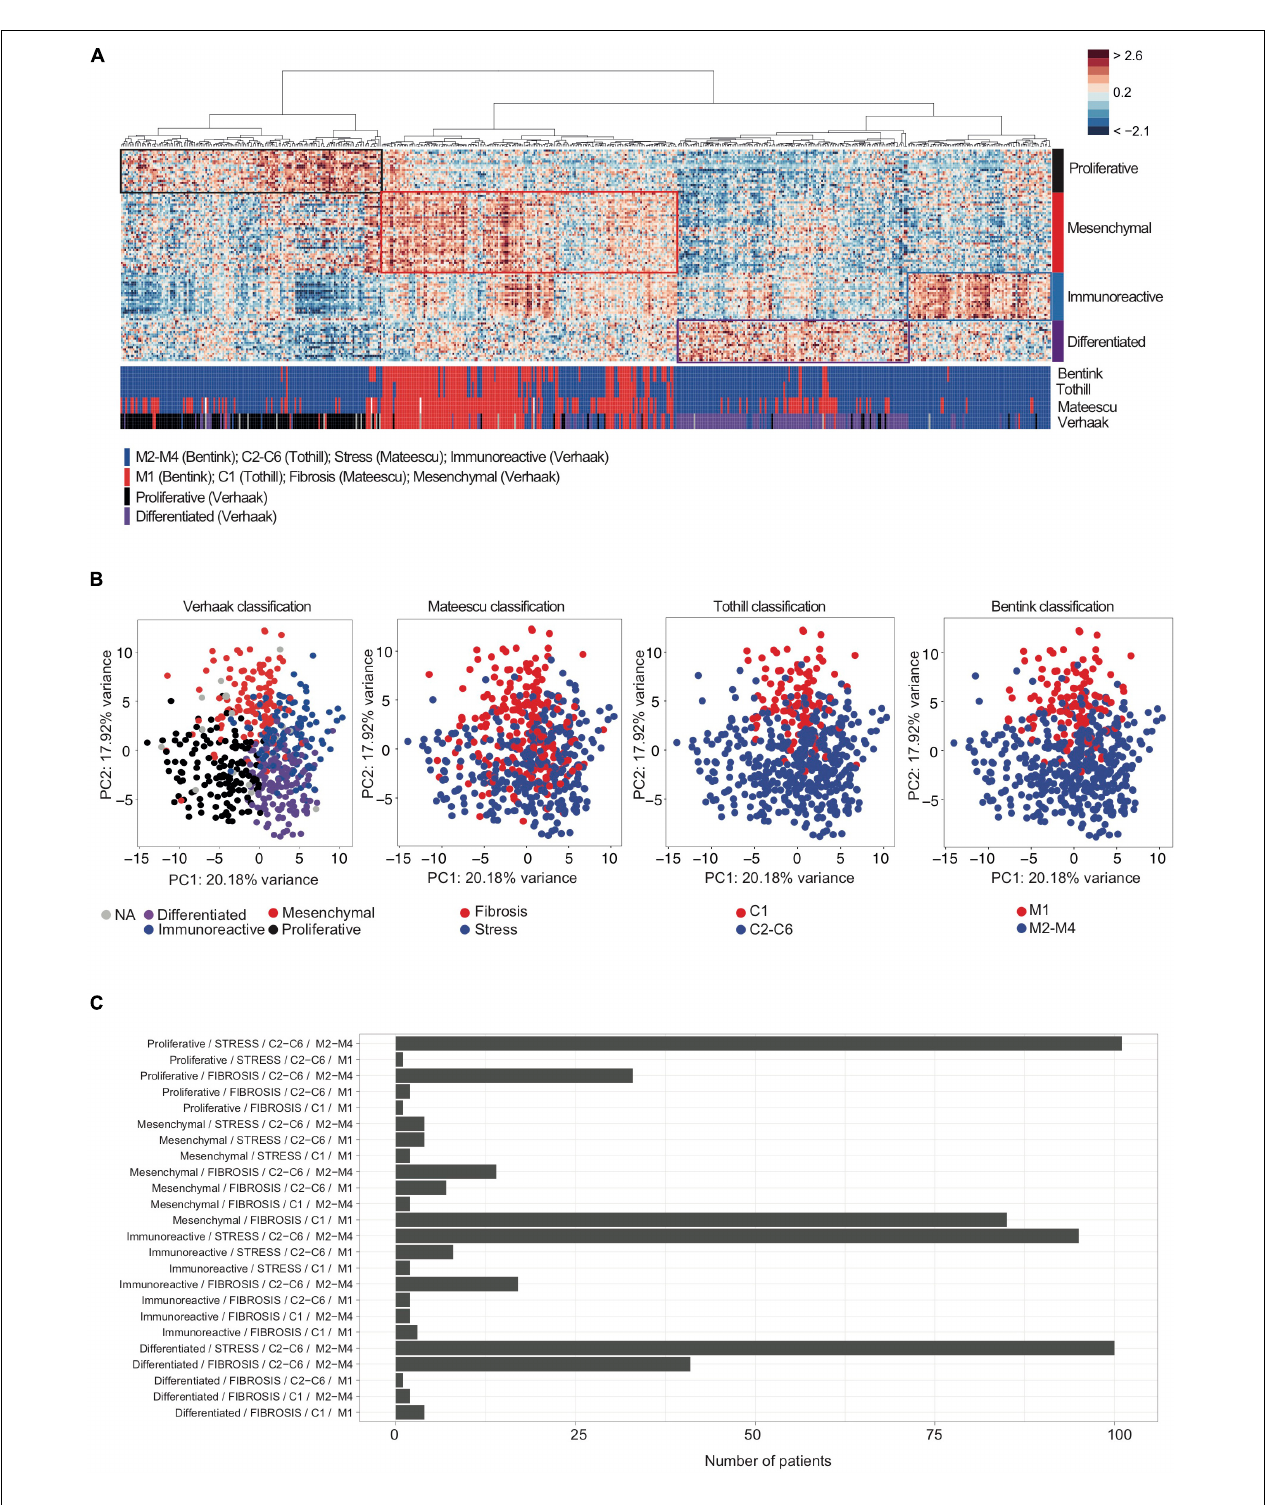
FIGURE 1 | Overlap between transcriptomic signatures used for classification of high-grade serous ovarian cancers. (A) A heatmap from hierarchical clustering applied on the TCGA cohort. Rows represent genes and columns represent patients. Clustering is based on the 100 genes of the D-I-M-P signature (Verhaak et al., 2013) using Pearson distance and Ward’s agglomeration method. The color saturation shows the magnitude of the deviation from the mean for each gene, with red and blue indicating expression values above or below the mean, respectively. Colored bars below the heatmap represent tumor classifications obtained from the